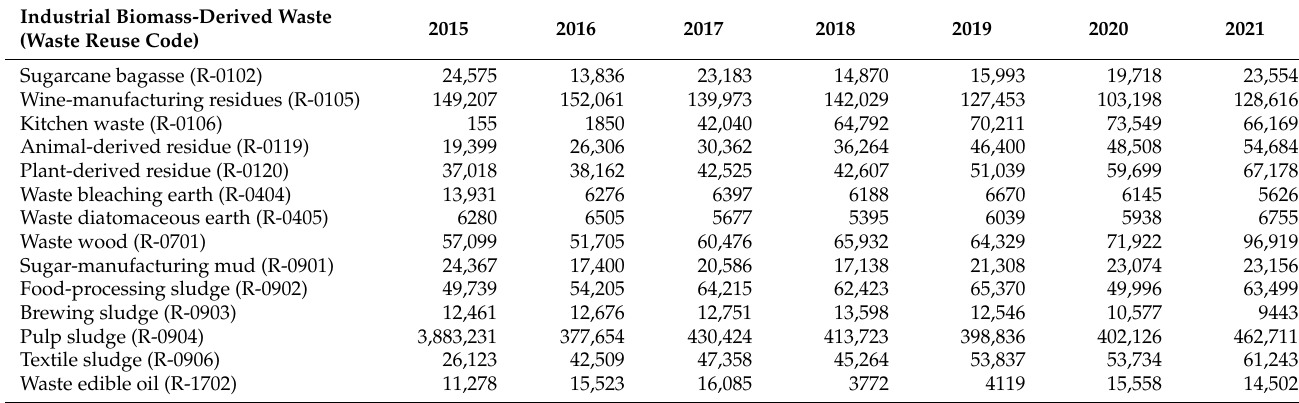
Table 4. Reported amounts of industrial biomass-derived waste generation potential for bioenergy production or fuel reuse in Taiwan